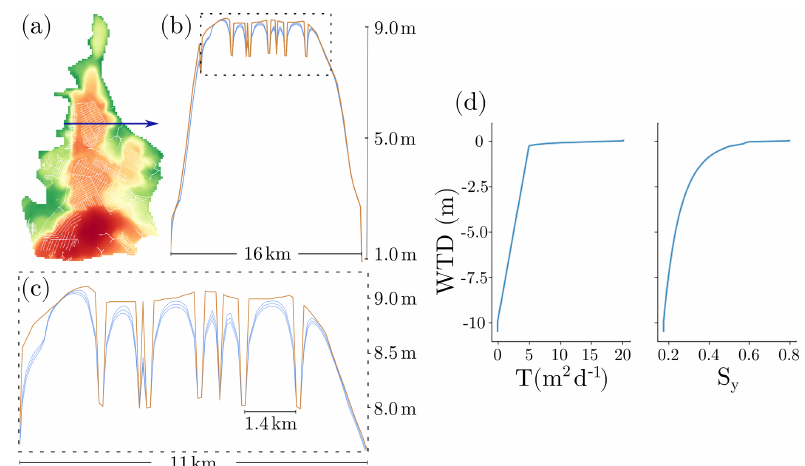
Figure 5. Cross section of the simulated WTD for 3 consecutive dry days after a big rainfall event and peat hydraulic properties. (a) DEM (colored) with the canal network superposed (white) and a straight horizontal blue line indicating the location of the cross section shown in panels (b) and (c) . (b) Peat surface (brown) and cross-sectional view of the WTD (blue) measured in meters above sea level. The multiple blue lines correspond to the WTD for the 3 consecutive days of dry down. Abrupt low peat surface values correspond to canals. The dashed rectangle shows the region magnified in the panel below. (c) Magnified area from the panel above. (d) Transmissivity, T (h) , and specific yield, S y (h) , functions for the deepest substrate (10m) hemic